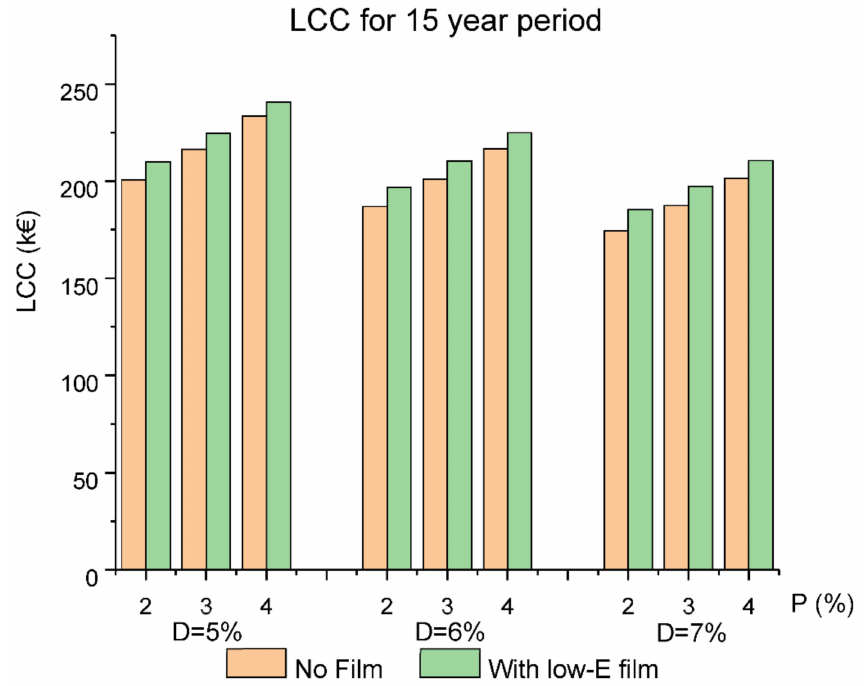
Figure 26. Life cycle cost for a calculation period of 15 years. Nominal discount rate (D) and price escalation (P) with inflation rate of 2%.